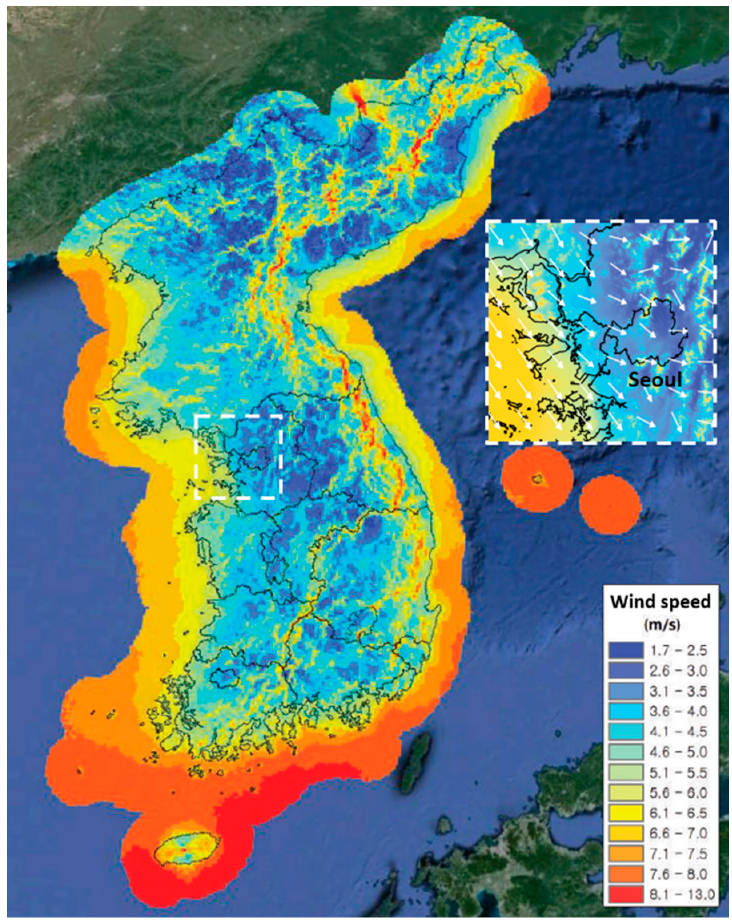
Figure 22. Wind resource map of the Korean Peninsula by Korea Institute of Energy Research (mean wind speed at 80 m aboveground).